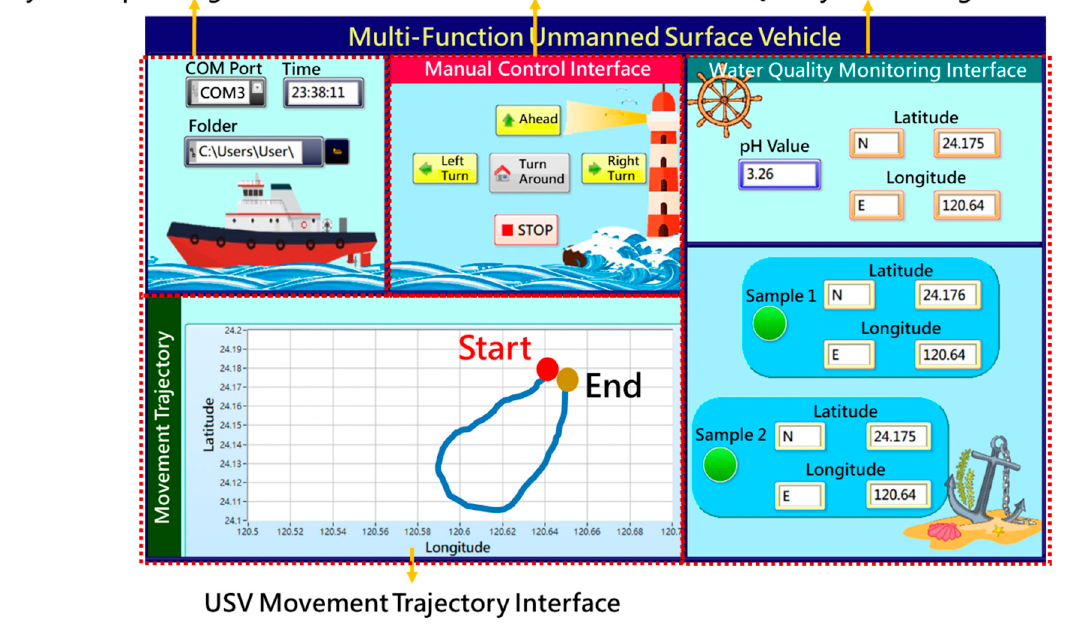
Figure 6. Remote human–machine interface.